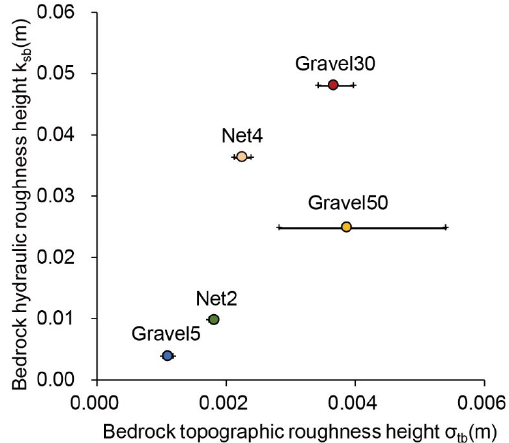
Figure 2. Relationship between initial bed hydraulic roughness height and topographic roughness height. The black circles in the image represent the average values measured on the three data col- lection lines, and the error bars represent the minimum and maxi- mum